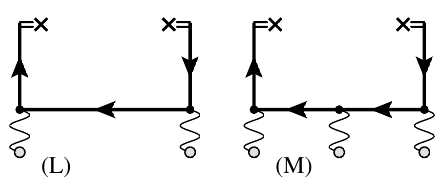
Figure 5 . The non-vanishing diagrams that mix quark and gluon operators. The bold lines denote the propagators of quantum (cid:12)elds. The thin lines with bubbles are background (cid:12)elds. The double dashed lines are Wilson lines and crosses show that they are pointing to light-cone